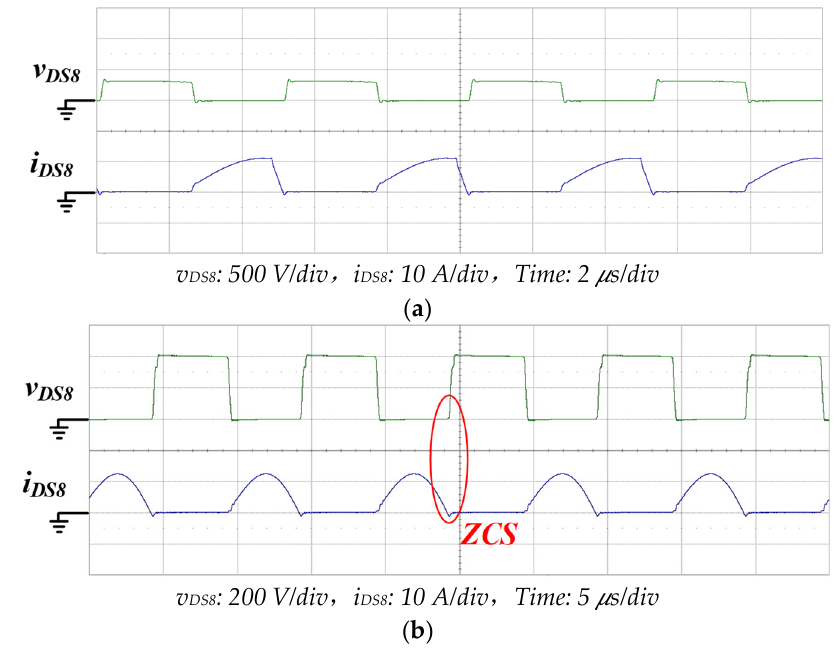
Figure 18. The vDS8 and iDS8 waveforms in G2V mode. ( a ) V DC Grid = 400 V ， V Vehicle_Bat = 280 V ， I Vehicle_Bat = 7.5 A; ( b ) V DC Grid = 400 V ， V Vehicle_Bat = 403 V ， I Vehicle_Bat = 7.5 A.